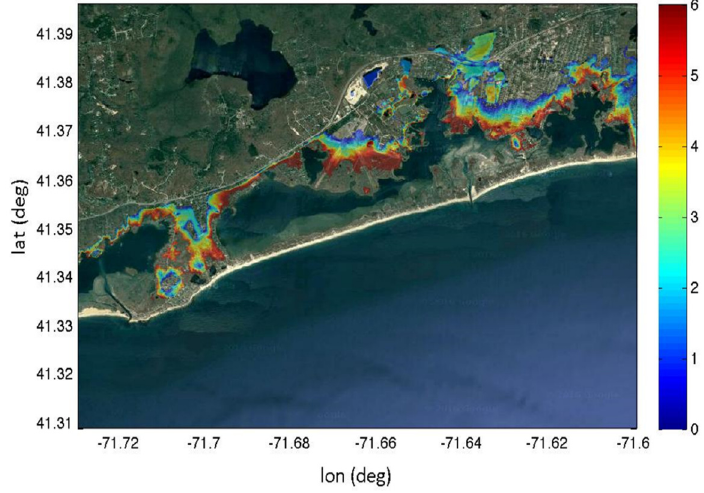
Figure A3. Total water depth (m) (inundation plus controlling wave height) for Charlestown, RI, 100 year event, plus 2.1 m (7 feet) of SLR, dune eroded.